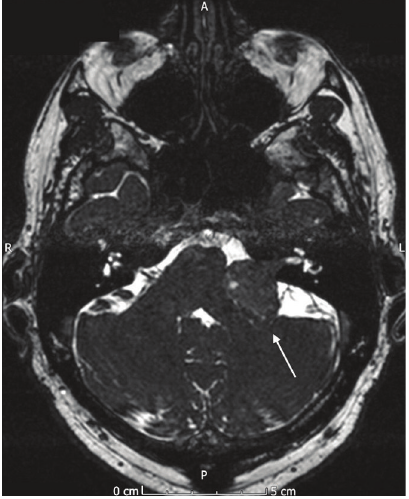
Figure 4: Axial MR image (T2 diffusion-weighted image) showing the vestibular schwannoma affecting the left vestibulocochlear nerve.